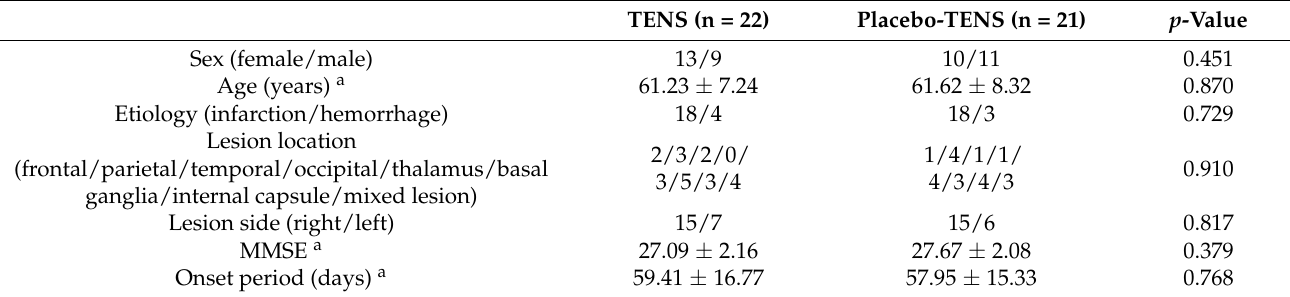
Table 1. Comparison of general characteristics between the two